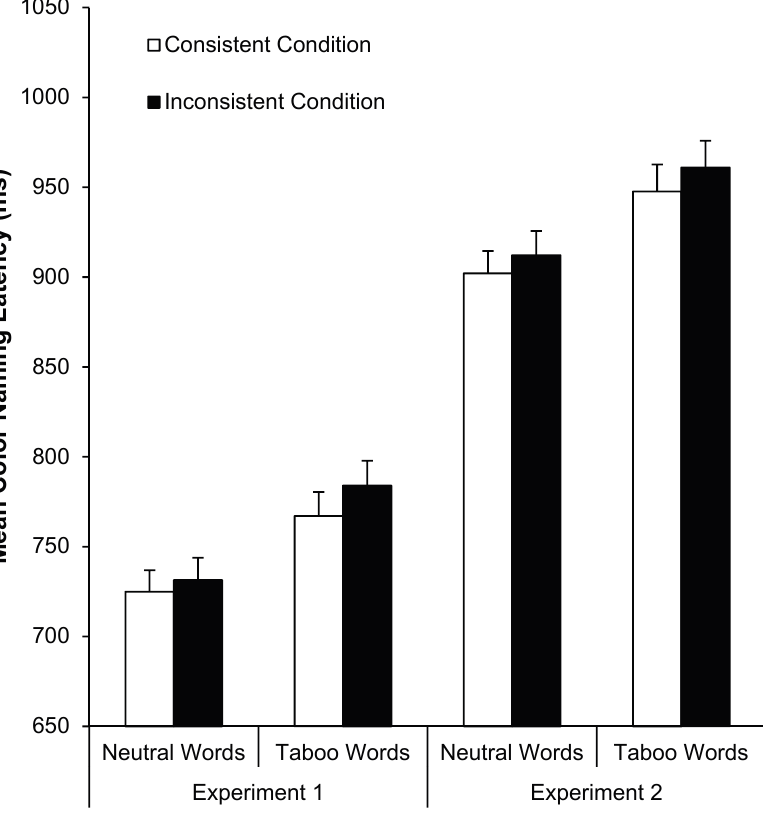
Figure 6. Mean color-naming RTs (+ SE ) as a function of word type and consistency in Experiments 1 (left panel) vs. 2 (right